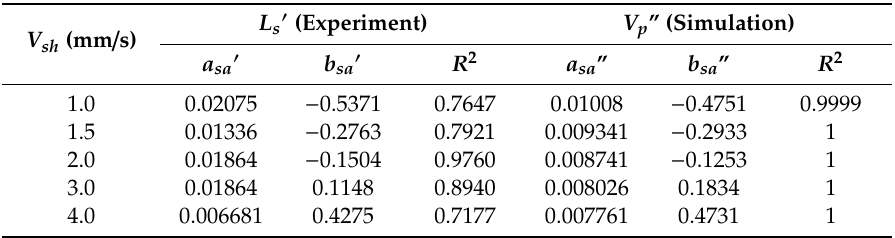
Figure 11 show the images of water sample 2 taken by the prototype at three di ff erent sheath flow rates. The smear of H. akashiwo was not as sensitive as that of the polystyrene bead to di ff erent shear flow velocities. At the theoretically optimal sample and sheath flow rates, the smear of the H. akashiwo was not very significant, and the shape of the phytoplankton could be clearly identified (Figure 11b). In contrast, with the faster sheath velocity, the shape of the phytoplankton became blurred (Figure 11c). The results indicated that the theoretically optimal sample and sheath flow rates obtained in this study are applicable to the microscopic imaging